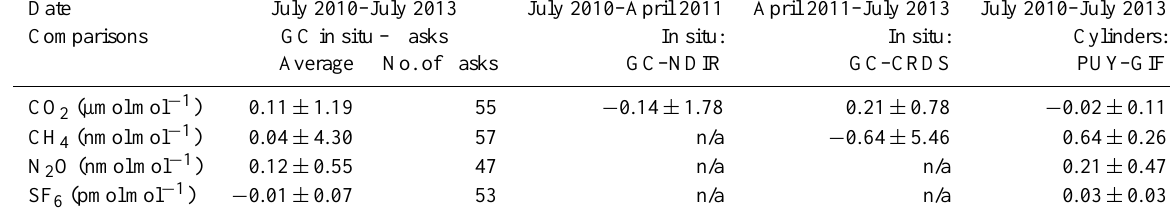
Table 6. Results of the comparisons between in situ measurements obtained using the GC system, NDIR, CRDS and flask measurements. The mean differences in the cylinder analysis at the Puy de Dôme and Gif-sur-Yvette stations are presented in the last column. Flasks and cylinders were analyzed at the LSCE central lab at Gif-sur-Yvette.